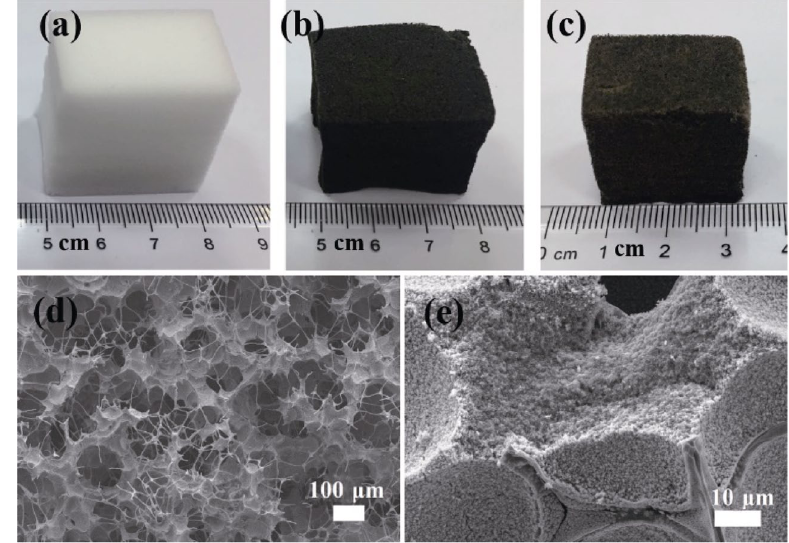
Fig. 6 (a) Photograph of one typical melamine foam. Photographs of the dried hybrid foams infiltrated with sols of (b) high viscosity and (c) low viscosity. (d) and (e) SEM images of the 1500 ℃ -pyrolyzed foams impregnated with sols of viscosity 4.3 cP, 1500 ℃ in vacuum for 1 h [49]. Reproduced with permission from Ref. [49], © Springer Science+Business Media, LLC, part of Springer Nature